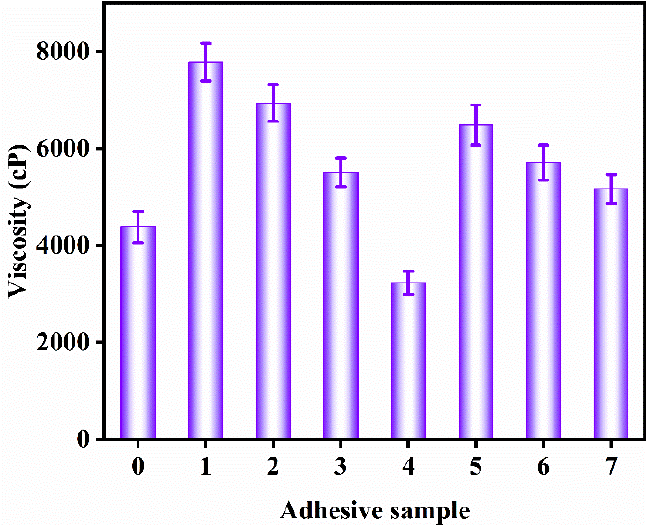
Figure 6. The viscosity of the different adhesive samples: (0) HPM adhesive, (1) HPM-papain adhesive, (2) HPM-sodium dodecyl sulfate (SDS) adhesive, (3) HPM-urea adhesive, (4) HPM-PAE adhesive, (5) HPM-papain-PAE adhesive, (6) HPM-SDS-PAE adhesive, (7) HPM-urea-PAE adhesive.